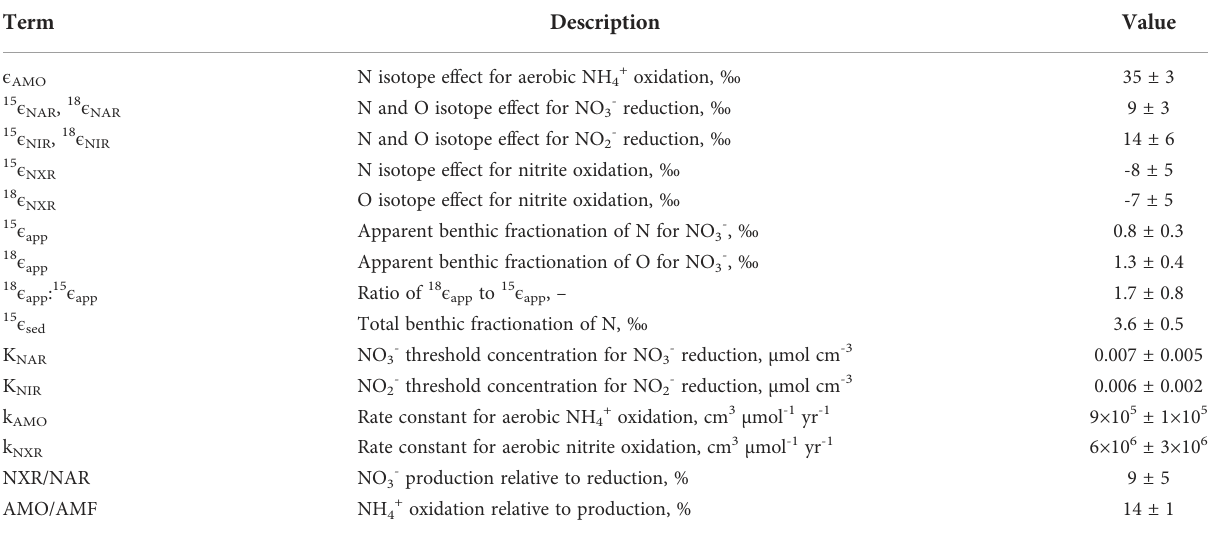
TABLE 3 Key model results for the Mauritanian shelf a .